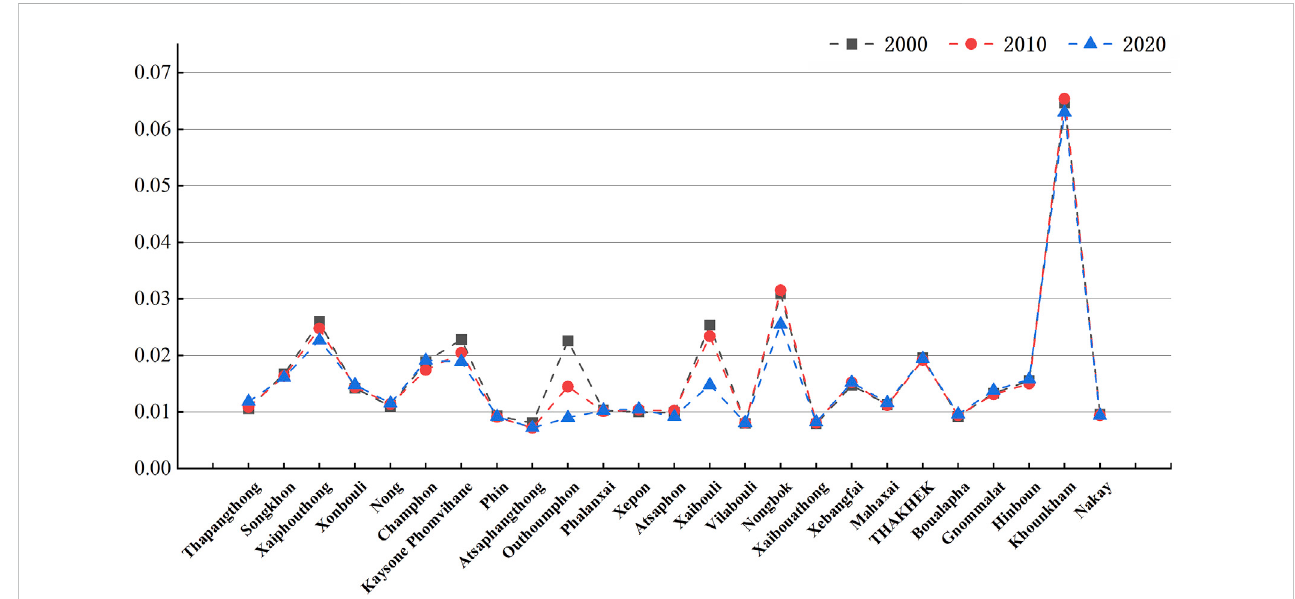
FIGURE 4 Landscape ecological risk index of 25 cities in Savan District from 2000 to